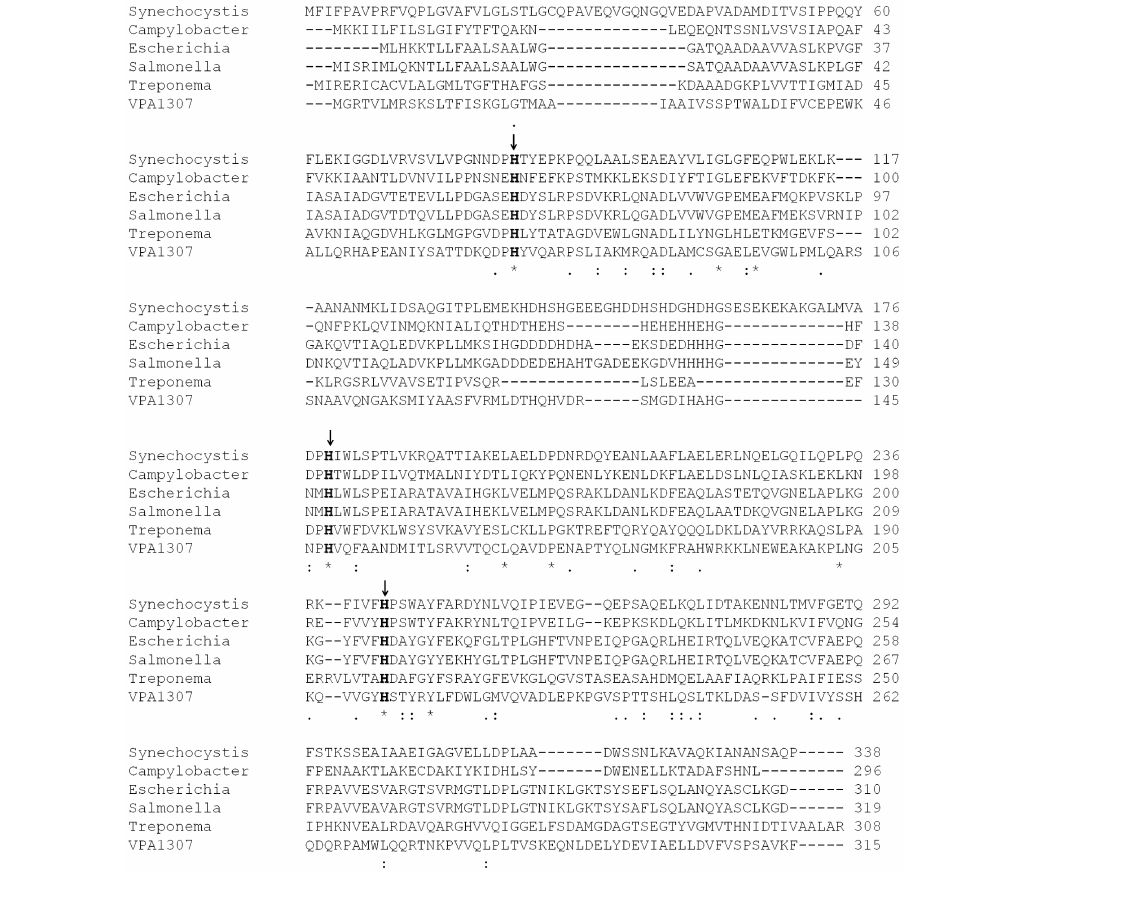
FIGURE 2 | Multiple sequence alignment of Vpa1307 and ZnuA proteins. The amino acid sequences (GenBank accession No.CAB72627, P73085, AAC74927, Q8Z5W7, AAC45725, and Vpa1307 from C. jejuni ,